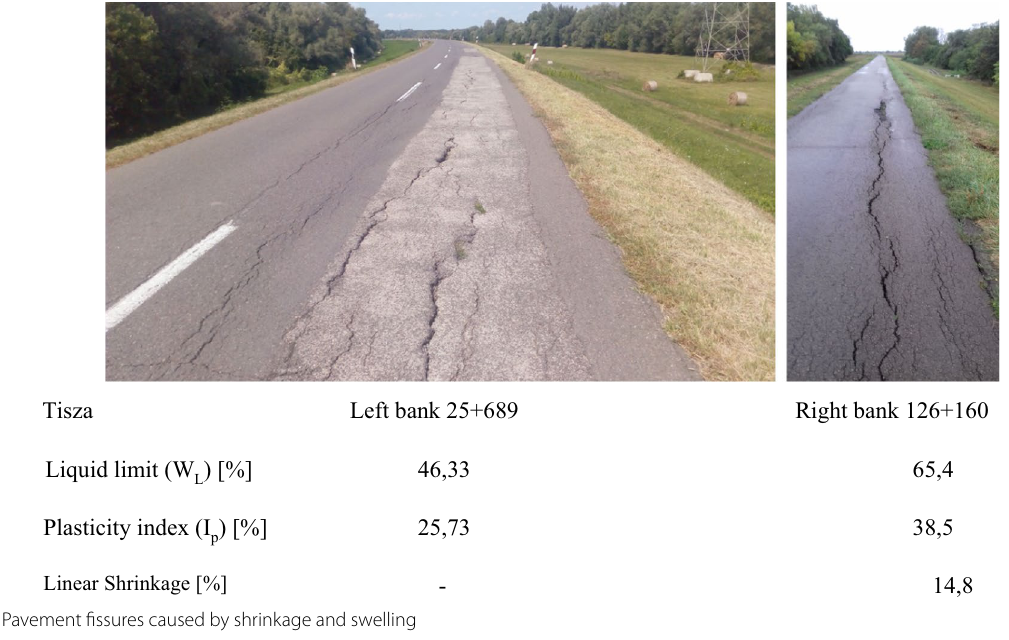
Fig. 12 Pavement fissures caused by shrinkage and